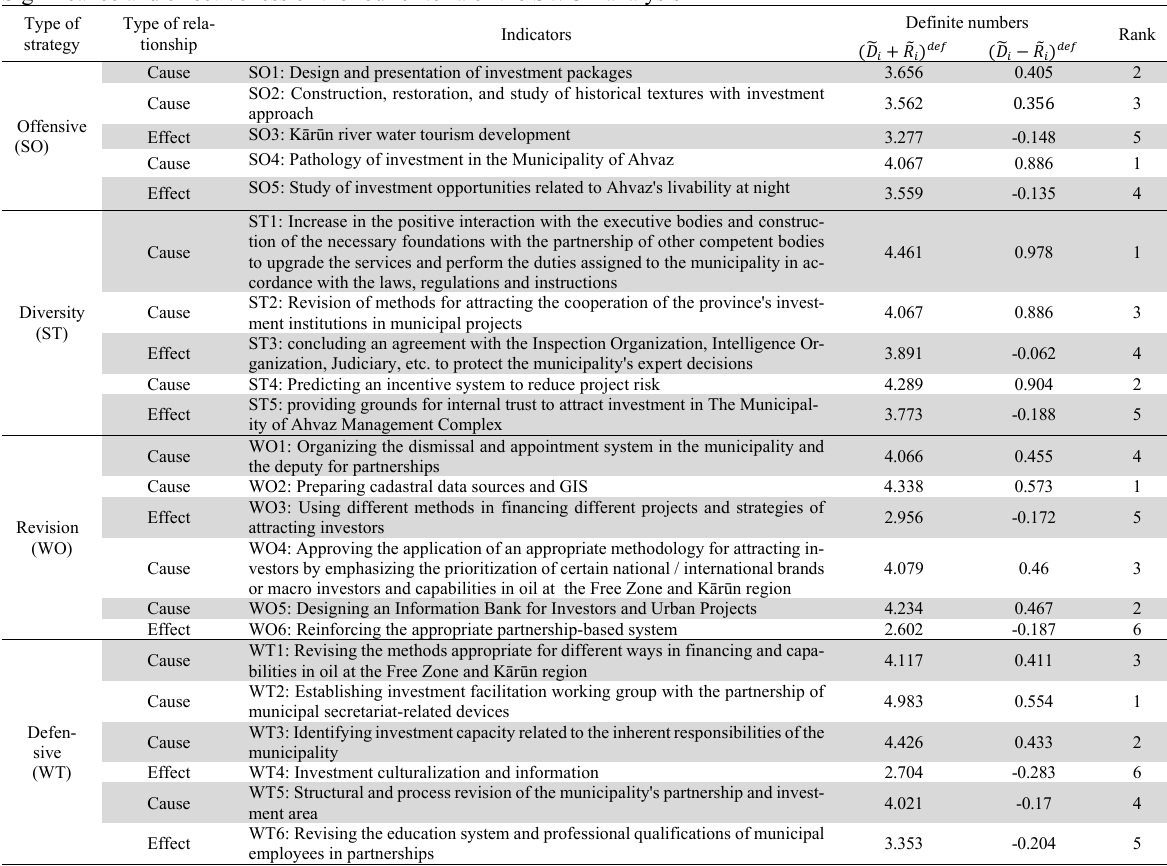
Significance and effectiveness of the four criteria of the SWOT analysis Type of Type of rela- strategy